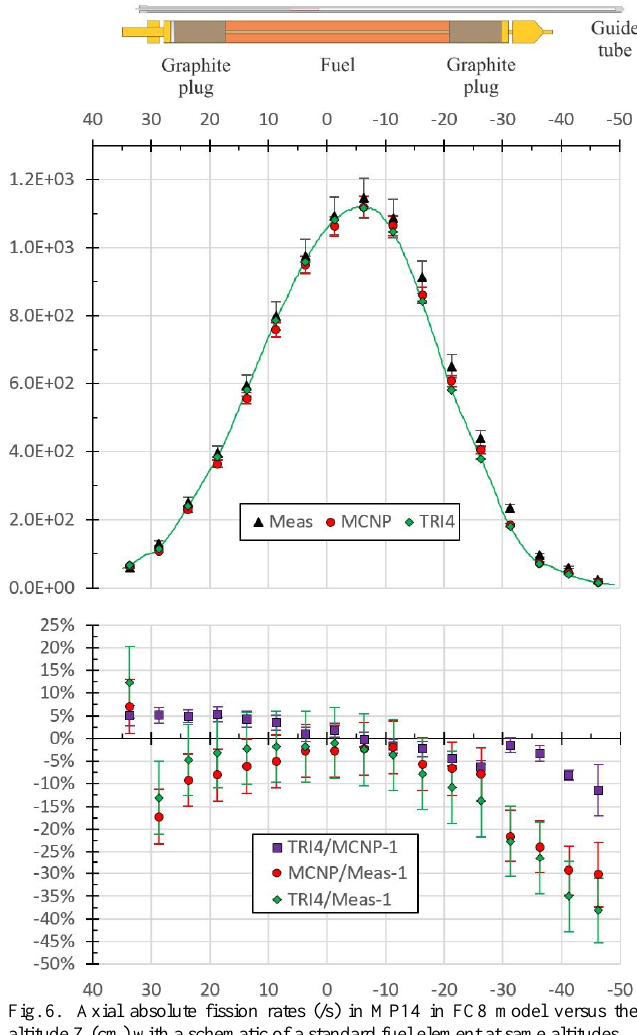
Fig. 6. Axial absolute fission rates (/s) in MP14 in FC8 model versus the altitude Z (cm) with a schematic of a standard fuel element at same altitudes.